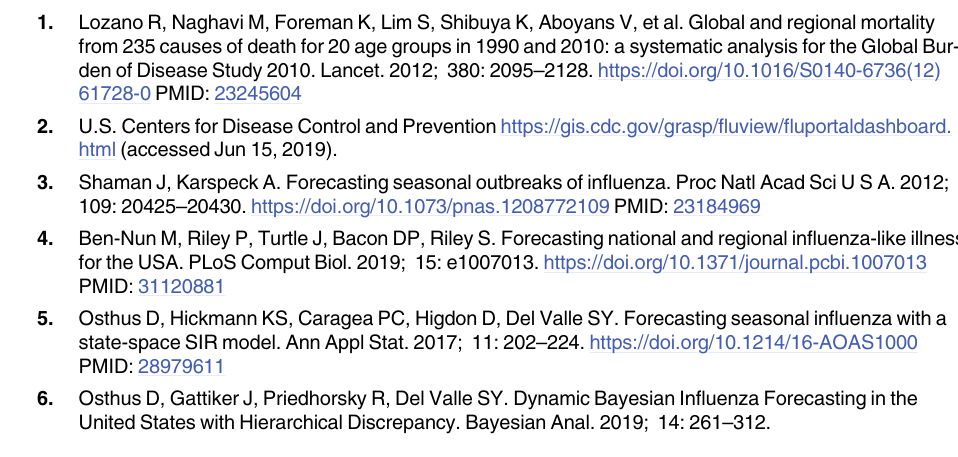
S19 Fig. Forecasting influenza using the method of analogues in multi-pathogen forecast- ing. We compare the log scores for seven targets averaged over weekly predictions in 15 sea- sons and 10 locations (national and 9 HHS regions). Forecasts were obtained using the multi- pathogen method in which influenza types/subtypes were predicted using dynamical models (Dynamic), the multi-pathogen method in which influenza types/subtypes were predicted using the method of analogues (Analogues) and the baseline single-pathogen method (Base- line). (EPS) S20 Fig. Degradations of forecasts if each pathogen is removed from the multi-pathogen forecasting system. We compare the log scores for seven targets averaged over weekly predic- tions in 15 seasons and 10 locations (national and 9 HHS regions). We removed each pathogen in turn in the multi-pathogen forecasting system and compared the degradation of log score.